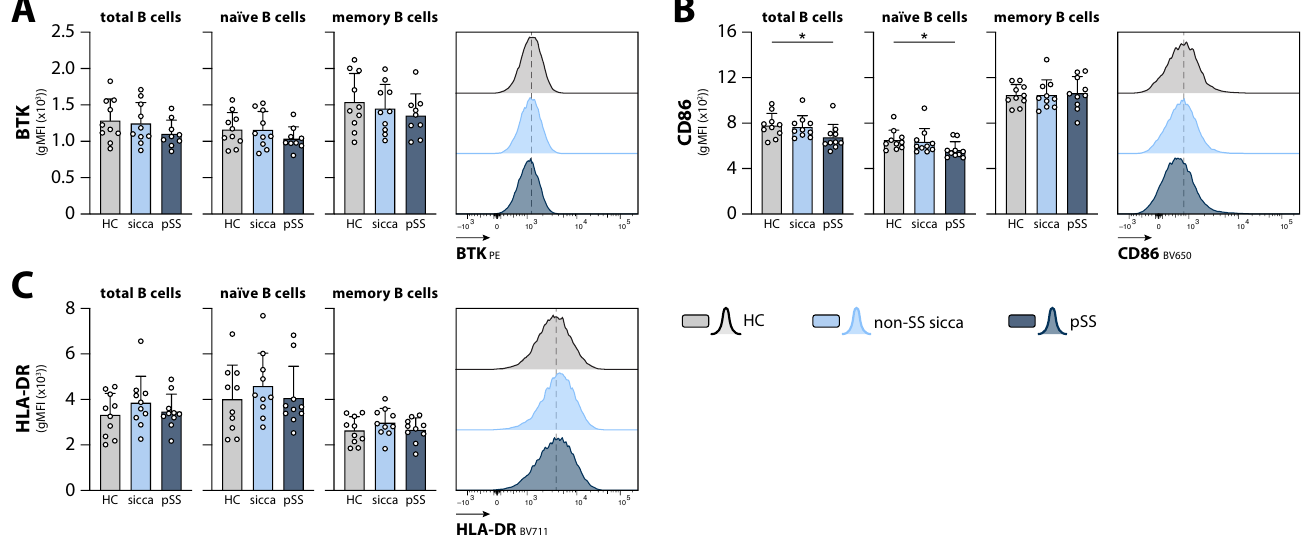
Figure 2. Expression of BTK and activation markers in circulating B cells from non-SS sicca patients, pSS patients, and HCs. Expression of ( A ) intracellular BTK protein, ( B ) surface CD86, and ( C ) surface HLA-DR on circulating total, naïve, and memory B cells. Representative histograms are shown for total B cells. Bars indicate mean + SD. * p < 0.05 by Kruskal–Wallis test with Dunn’s correction for multiple